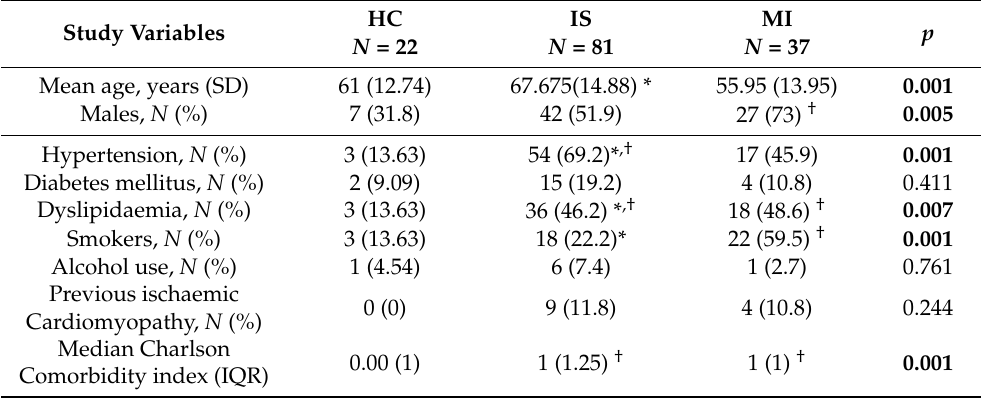
Table 1. Demographic data, vascular risk factors and clinical data of the patient cohort and healthy controls at admission.